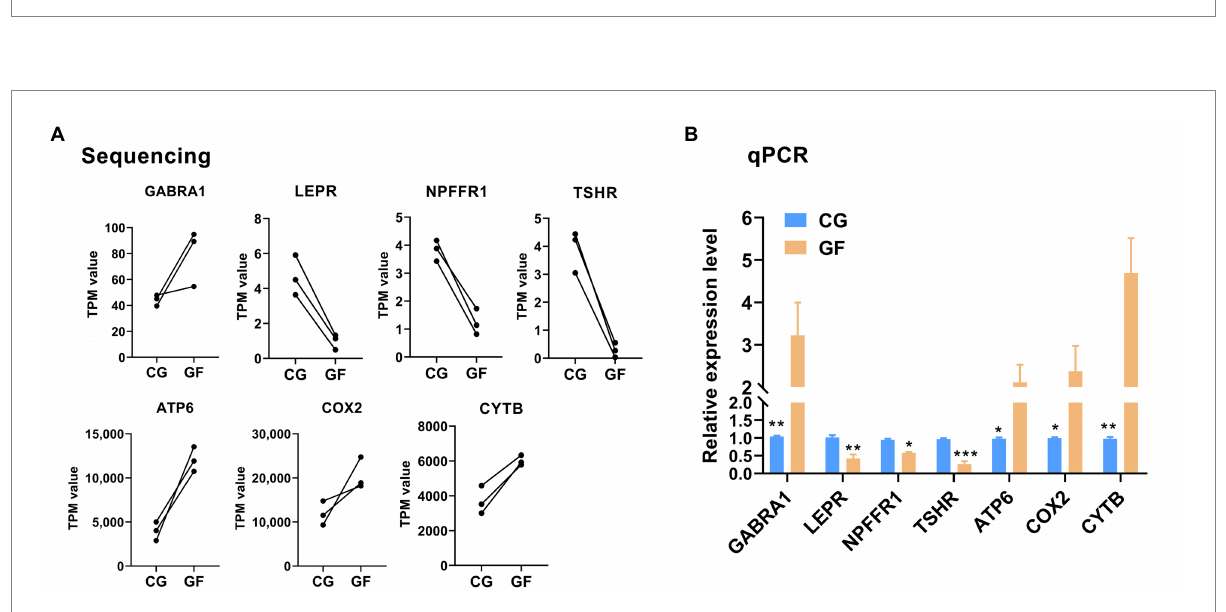
FIGURE 4 RT-qPCR validation of the RNA-Seq expression results. (A) The sequencing data for four DE genes ( NPFFR1 , GABRA1 , LEPR , and TSHR ) in the neuroactive ligand–receptor interaction and three DE genes ( COX2 , ATP6 , and CYTB ) in oxidative phosphorylation. (B) RT-qPCR data for the genes. The data are presented as the means ± SEM. n = 3. **indicates p < 0.01, * indicates p < 0.05 between CG pigs and GF pigs. *** indicates p < 0.001.